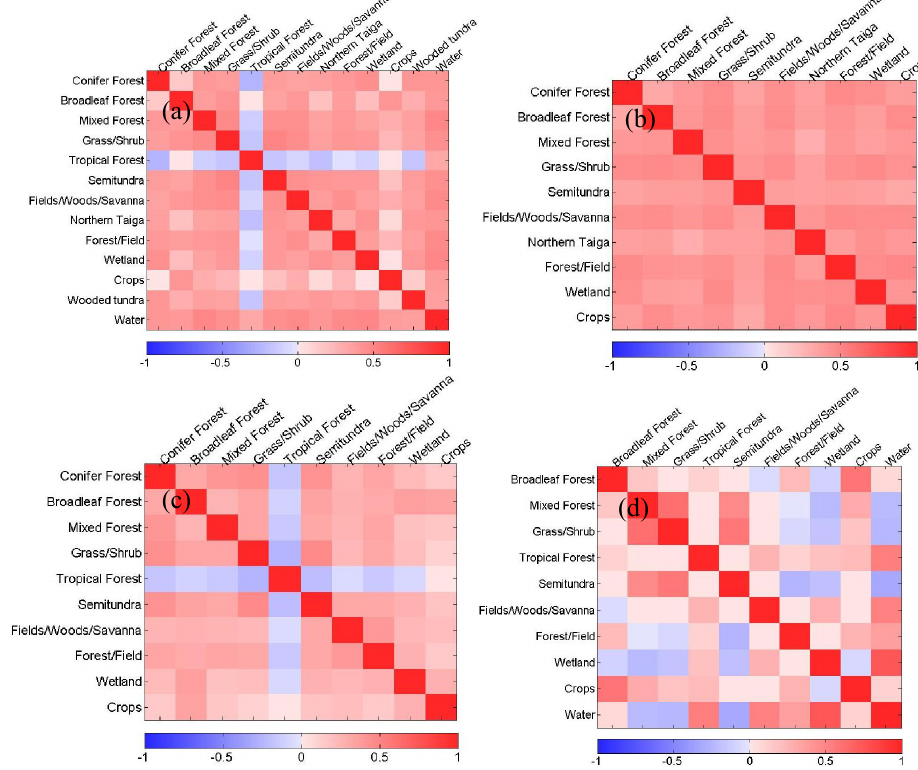
Figure 5. The matrixes of the ecosystem-by-ecosystem paired correlations for the optimized carbon fluxes during the period 2006–2010 are (a) Asia; (b) boreal Eurasia; (c) temperate Eurasia; (d) tropical